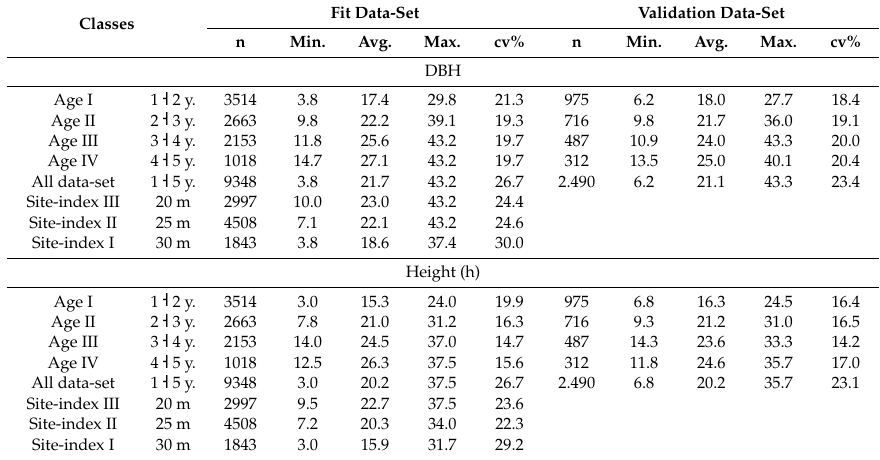
DBH = diameter at breast height (cm), h = total height (m), Min. = minimum value, Max. = maximum value, Avg. = average, s = standard deviation (±), cv% = coefficient of variation in percentage, y. = years. 2.1.2. Site-Index The effects of site-index on height–diameter relationship were only assessed for the fit data-set; namely, site-index was only used to assess model fit and not validation. Measurements of dominant height—h dom (m) of the 100 largest trees per hectare were done following Assmann [28]. See Table 2 for descriptive statistics. Table 2. Descriptive statistics of variables used in modelling of h dom for Ochroma pyramidale (balsa-tree) stands in Ecuador. Variable Minimum